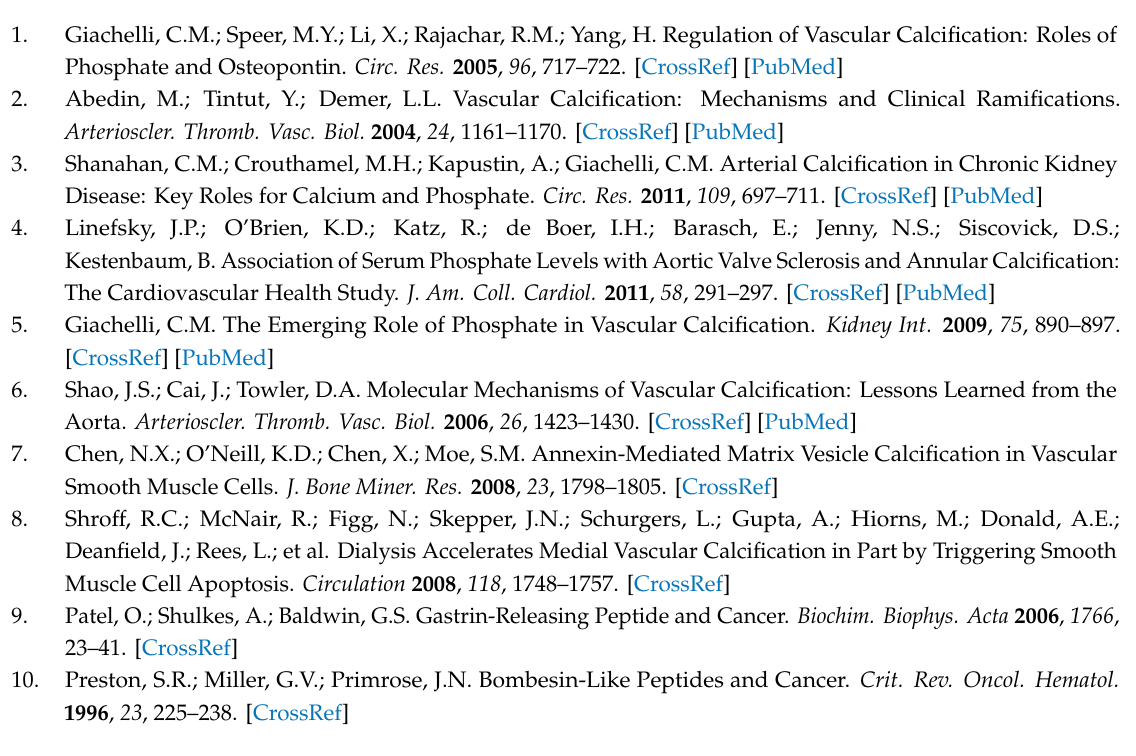
Figure S1: E ff ect of exogenous GRP on Pi-induced calcification of A7r5 cells, Figure S2: E ff ect of GRP knockdown on Pi-induced calcification of A7r5 cells, Figure S3: E ff ect of GRP inhibition on Pi-induced calcification markers and activation of Smad 1 / 5 and ERK / MAPK pathways in VSMCs, Figure S4: E ff ect of RC-3095 on Pi-induced apoptosis and matrix vesicle release in VSMCs, Figure S5: E ff ect of RC-3095 on vascular calcification in HP-fed CKD mouse, Figure S6: GRP level in plasma and expression of GRP and GRP receptor in aorta from CKD rat model, Table S1: Primer sequences for real-time RT-PCR, Table S2: Physical and biochemical parameters in CKD